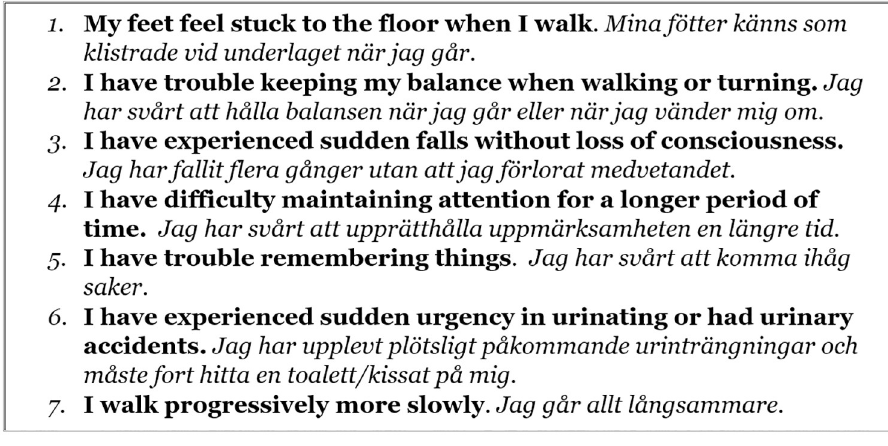
Fig 1. Screening questionnaire (“yes” or “no” answers) in English (bold) and Swedish (italics).